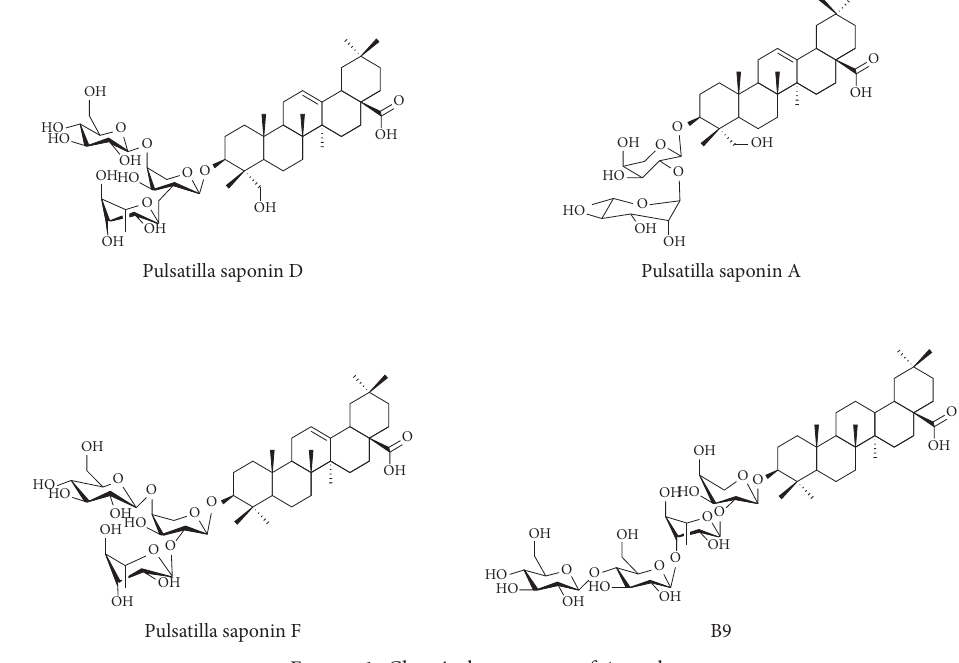
Figure 1: Chemical structures of 4 Table 1: Criteria of TCM quality by SQFM.